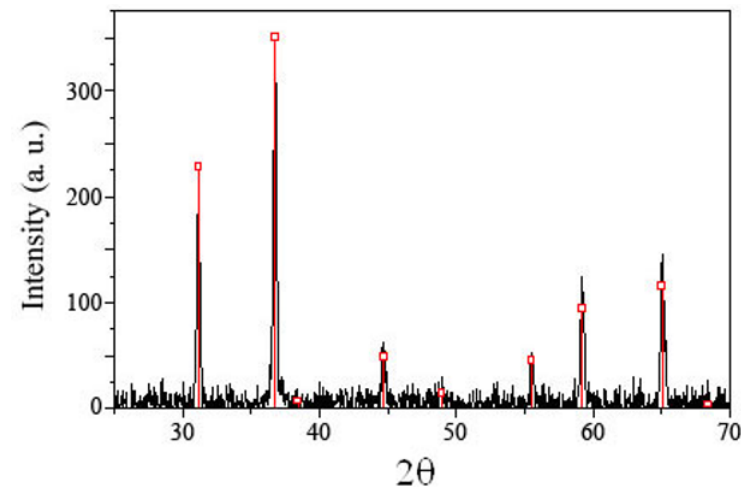
Figure 2. X-ray diffraction pattern of CoAl data for